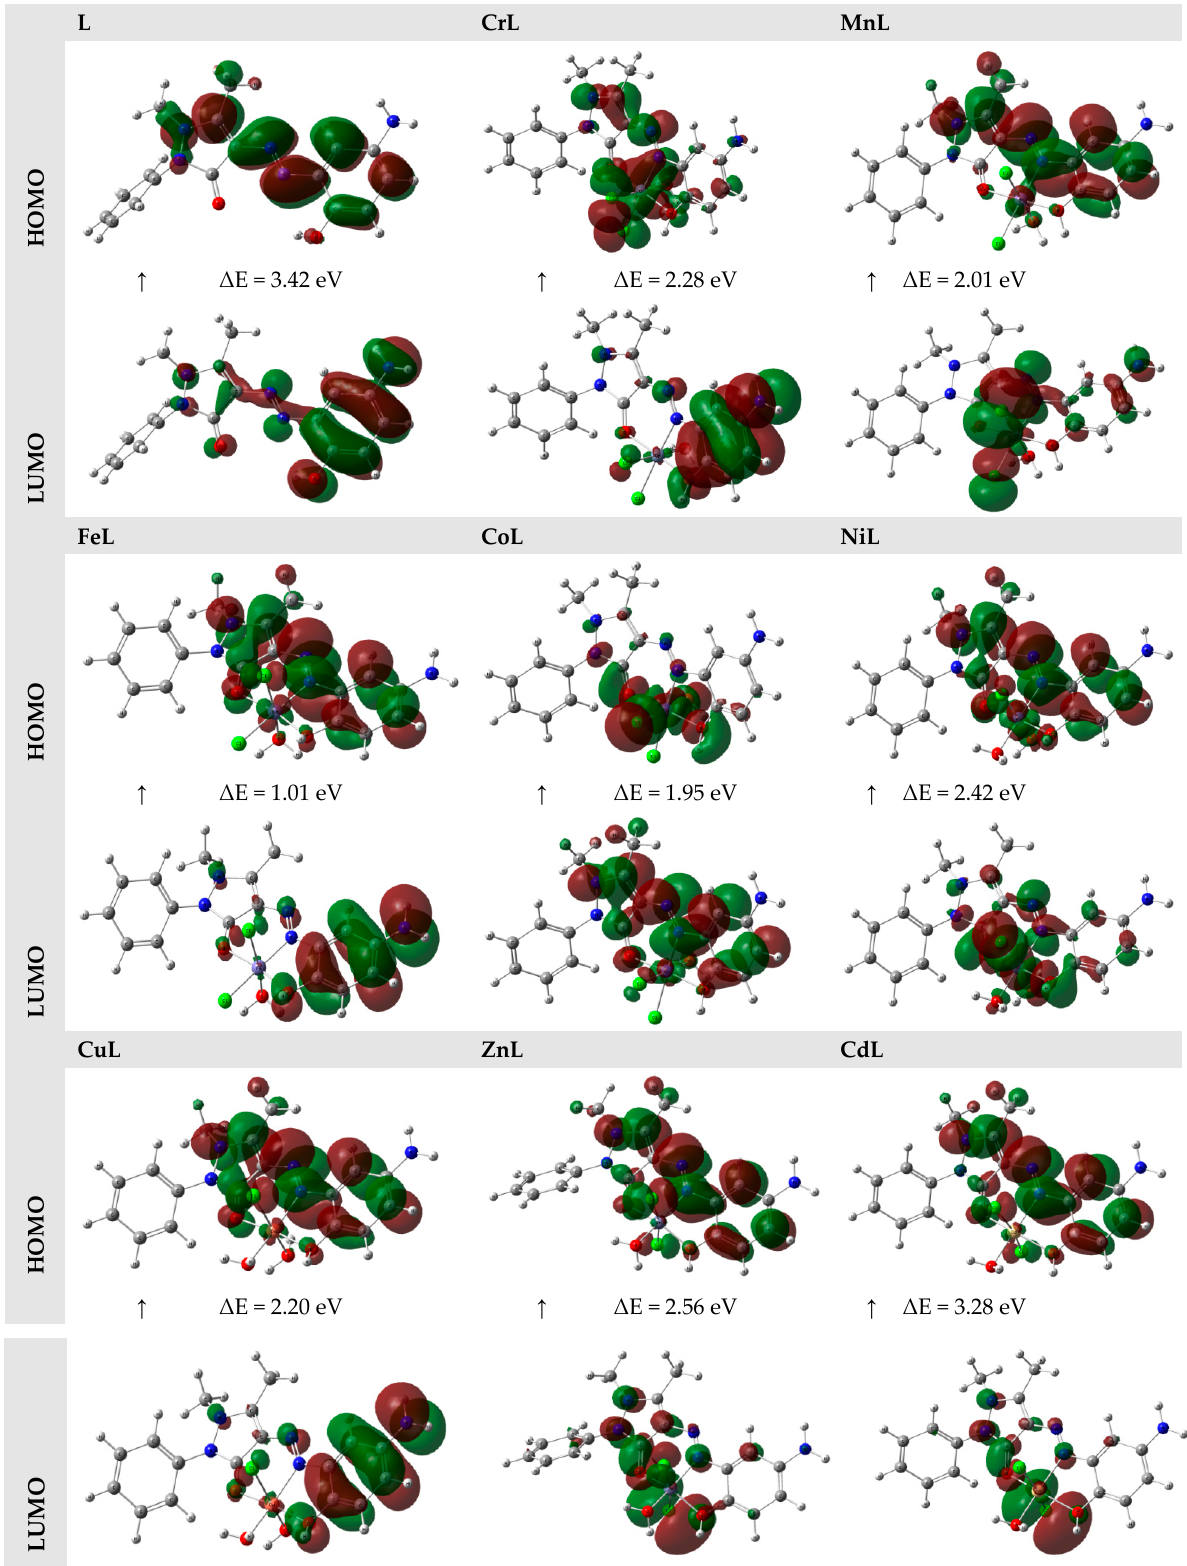
Figure 5. The HOMO and LUMO of the L, CrL, MnL, FeL, Co, NiL, Cu, ZnL, and CdL com- pounds.